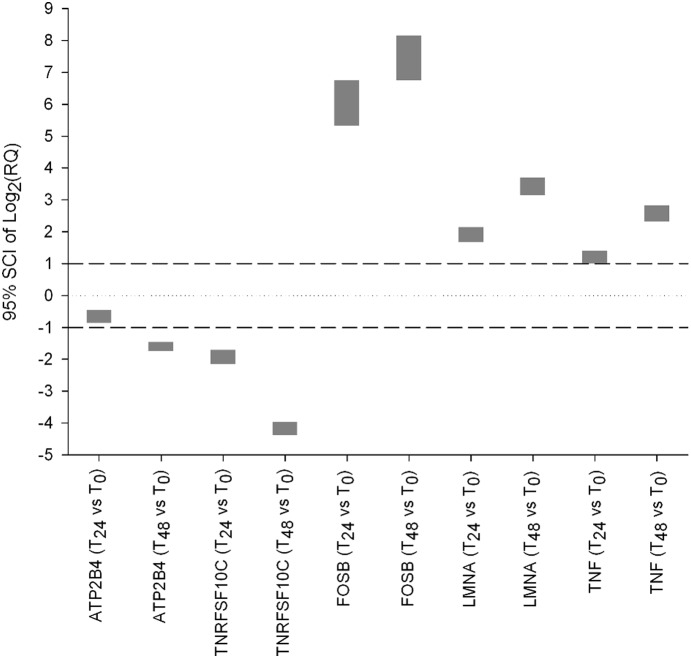
95% Simultaneous Confidence Intervals (SCIs) of the Log2 Relative Quantity (RQ) for the EDTA biomarkers.For each time point Tx (x≠0) the corresponding RQ was computed as 2−[ΔΔCq] where ΔΔCq = ΔCq markerTx−ΔCqmarkerT0.